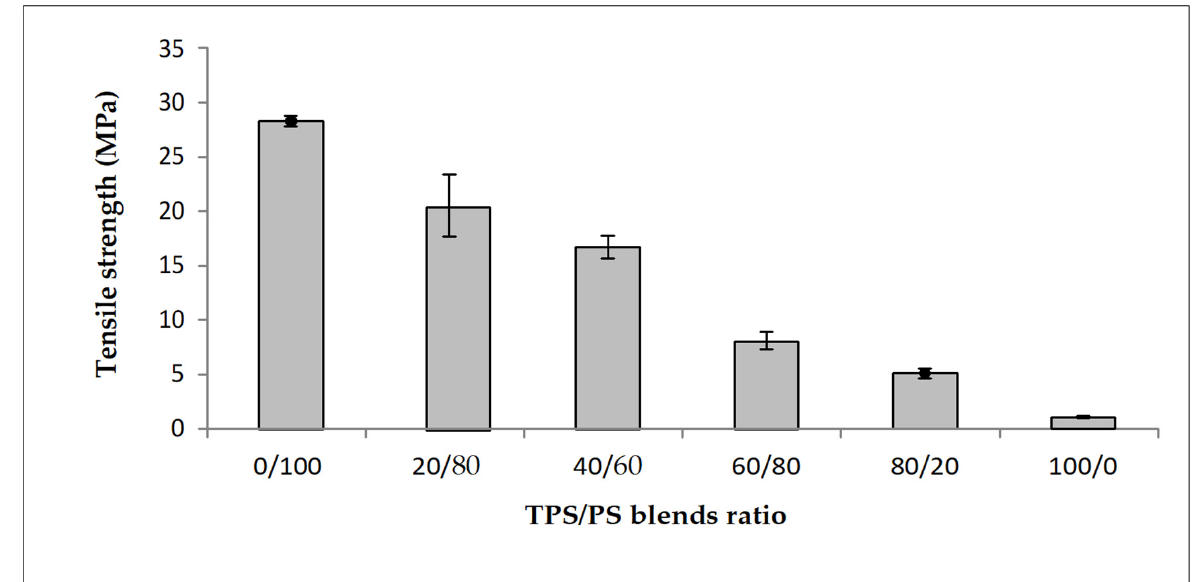
Figure 1. Tensile strength of untreated TPS/PS blends at different ratios.